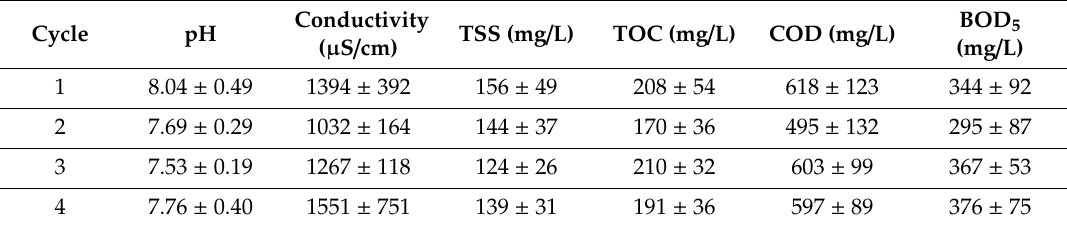
Table 2. Average values of pH, conductivity, total suspended solids (TSS), and organic matter concentration (Total organic carbon (TOC), chemical oxygen demand (COD), and BOD 5 ) of the influent during the experiments.